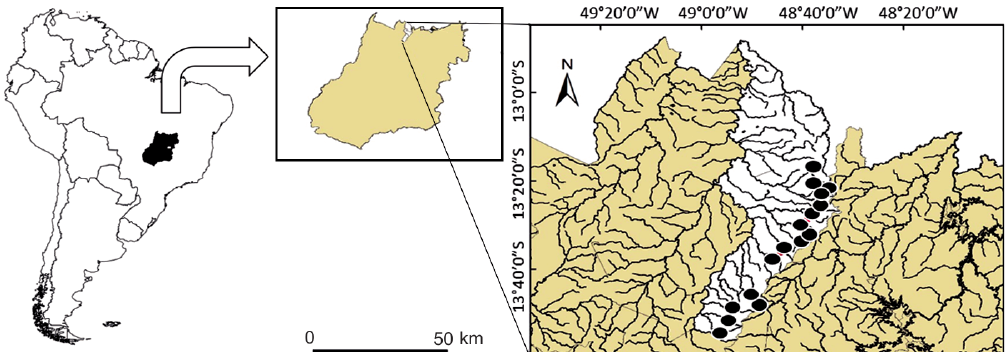
Figure 1. Map of South America highlighting the Goiás State (Brazil) and the sampling sites located in the Santa Tereza sub-basin, Upper Tocantins River